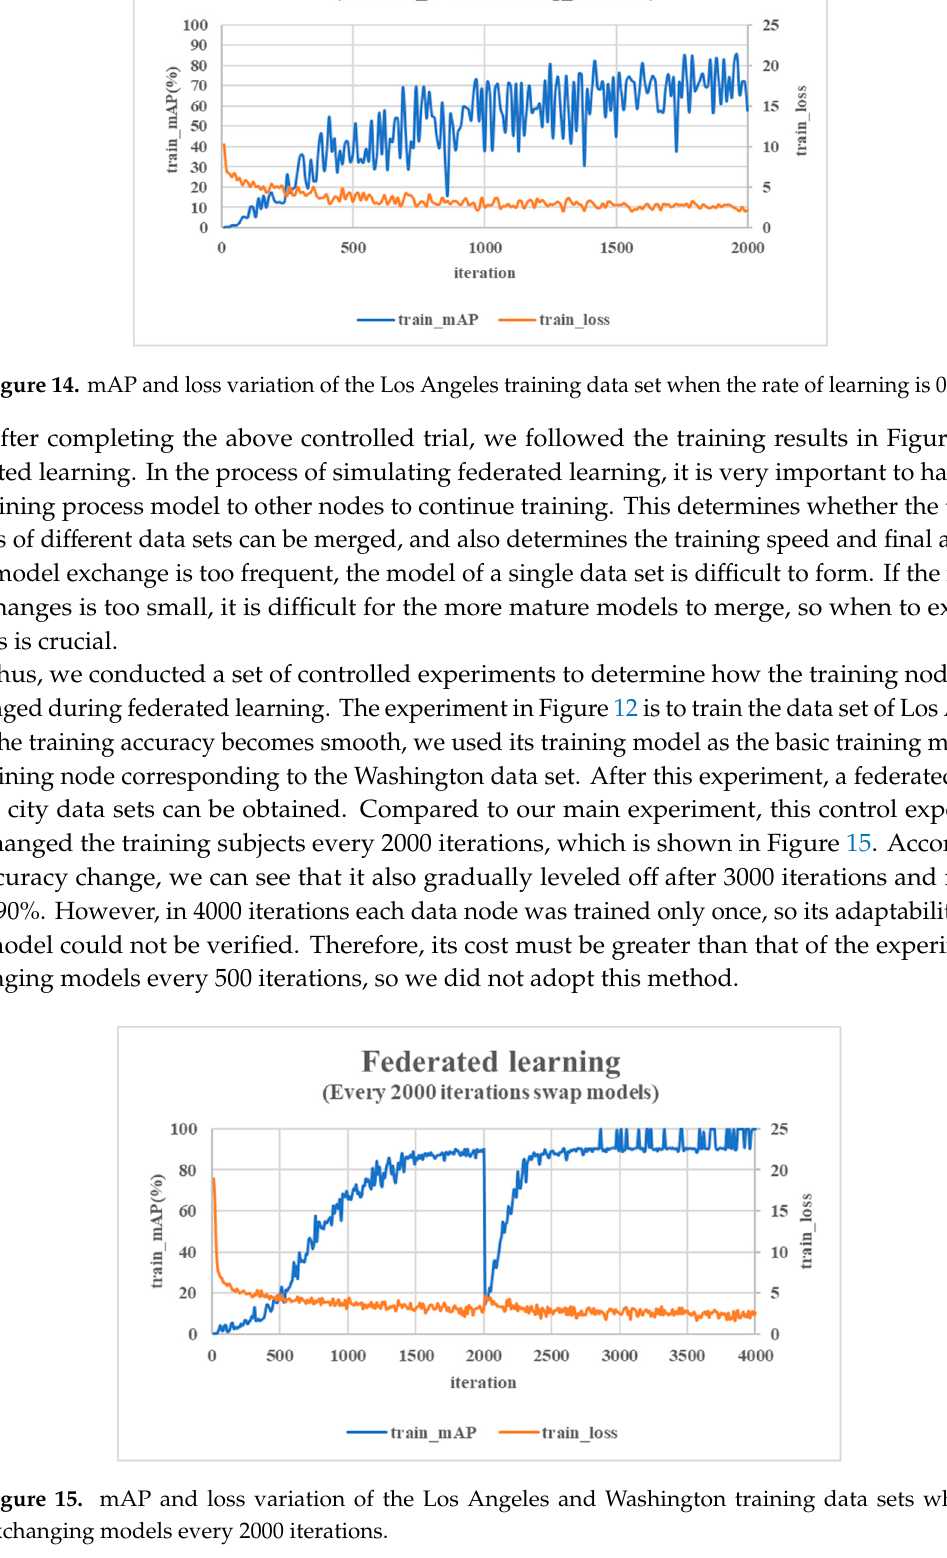
Figure 16. mAP and loss variation of the Los Angeles and Washington training data sets when exchanging models every 100 iterations. Thus, we moved to federated learning by training nodes with iterations every 500 times, so we needed to transfer the model once. In order to show the difference between the federal learning and the general deep learning methods for the data model formation process, we used the general method for the model training. In the general deep learning training comparison experiment, the data of the